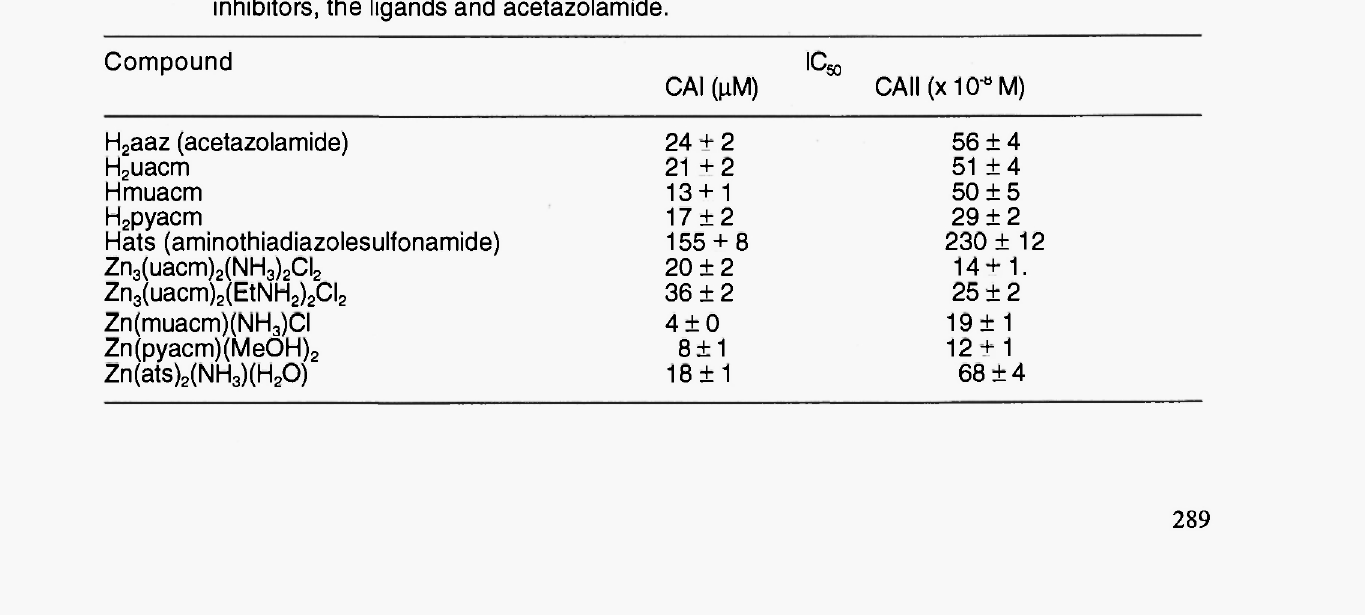
Figure 6. Ideaised structure of the coordination polyhedron of the metal in the [Zn(ats) 2 (NH 3 )](H 2 0) complex. A comparison of the results of these EHMO calculations with those of the one previously reported [Zn(macm) 2 (NH 3 ) 2 ] complex 22 shows that the two complexes have the HOMO and LUMO orbitals without contribution of the metal orbitals, in agreement with the crystal data of the CA- acetazolamide compound reported by Liljas et al 26 that have pointed out the importance of the thiadiazole ring interactions in the CA-inhibitor interaction. For the [Zn(5-amino-1,3,4-thiadiazole-2- sulfonamidate) 2 (NH 3 )].H 2 0 another important aspect to be note is the participation of the thiadiazole Ν orbitals in the principal FMOs due to the interaction of the nitrogen atom of the thiadiazole ring with the Zn(ll) ion. This fact is not observed in the [Zn(macm) 2 (NH 3 ) 2 ] complex, where only the nitrogen atoms from the sulfonamido groups were involved.